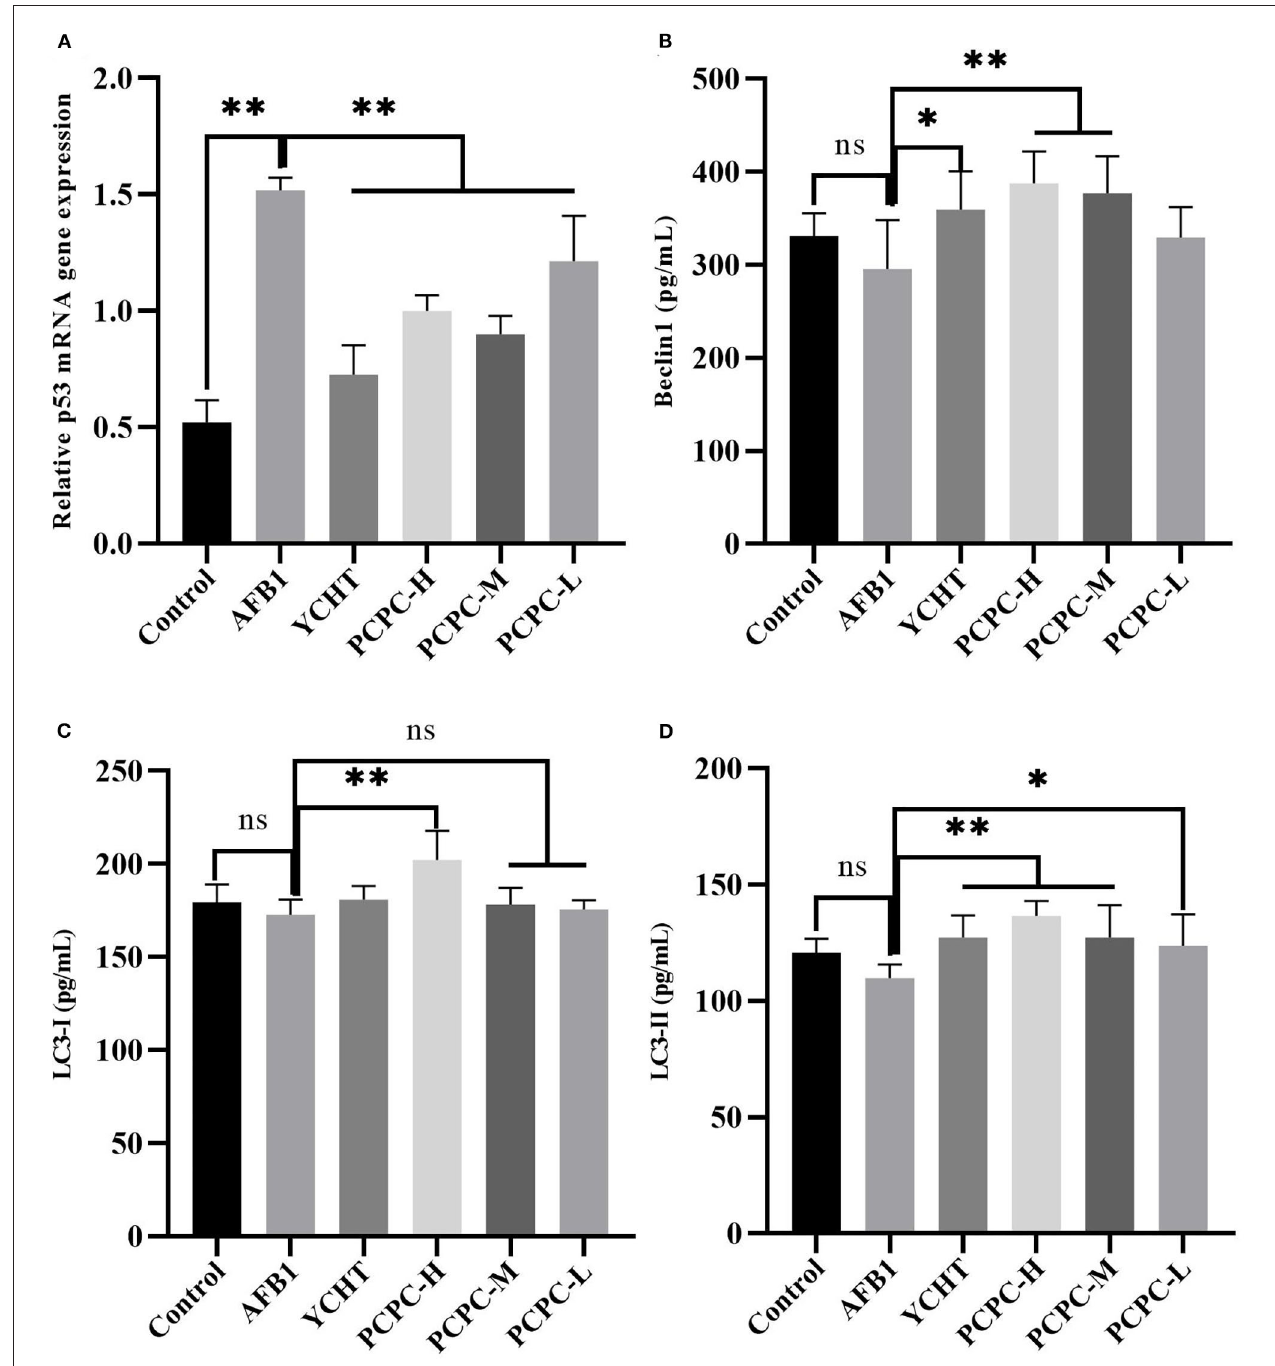
FIGURE 7 | Effect of PCPC and AFB 1 on autophagy-related genes (Beclin1, LC3-I and LC3-II, and p53) in kidneys. All data are expressed as mean ± SD. (A) p53; (B) Beclin1; (C) LC3-I; (D) LC3-II. Asterisk indicates significant difference ( p < 0.05) compared to the control and AFB1 group. * p < 0.05 and ** p < 0.01, ns,